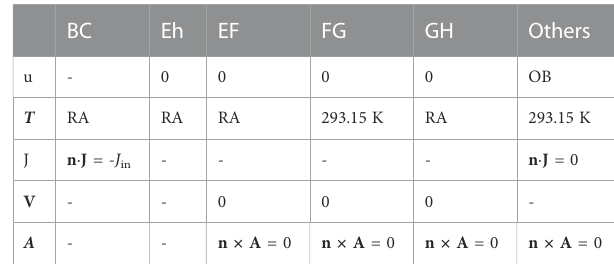
TABLE 1 Boundary conditions of the static arc